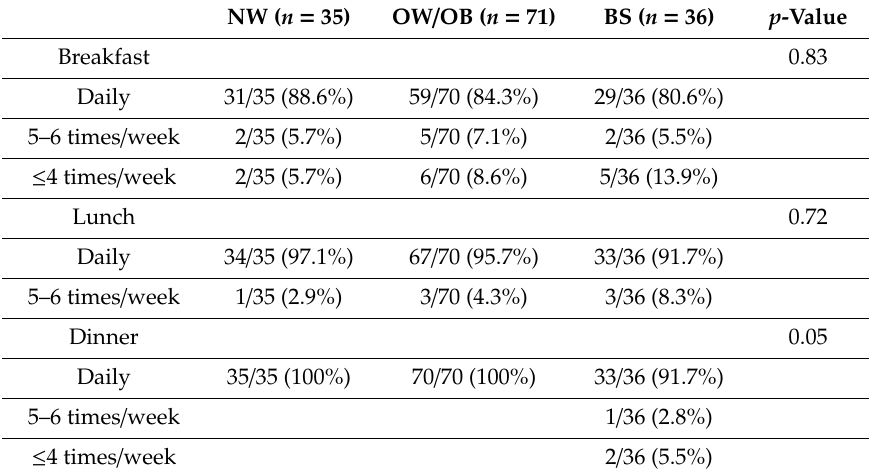
Table 3. Meal pattern of the